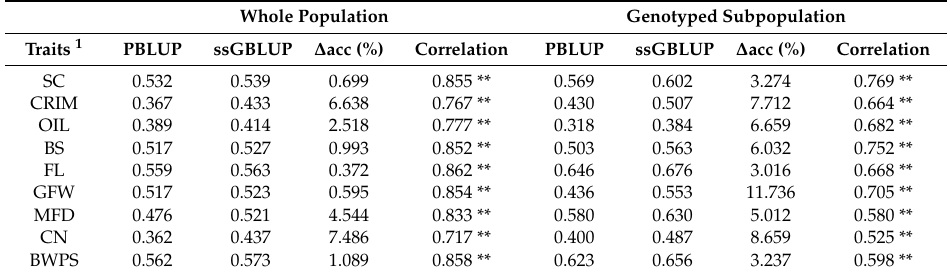
Table 4. Comparison of estimated breeding value (EBV) and genomic estimated breeding value (GEBV) accuracies (PBLUP and ssGBLUP) and increases in accuracy ( ∆ acc) obtained for the whole population and the genotyped subpopulation of Chinese Merino